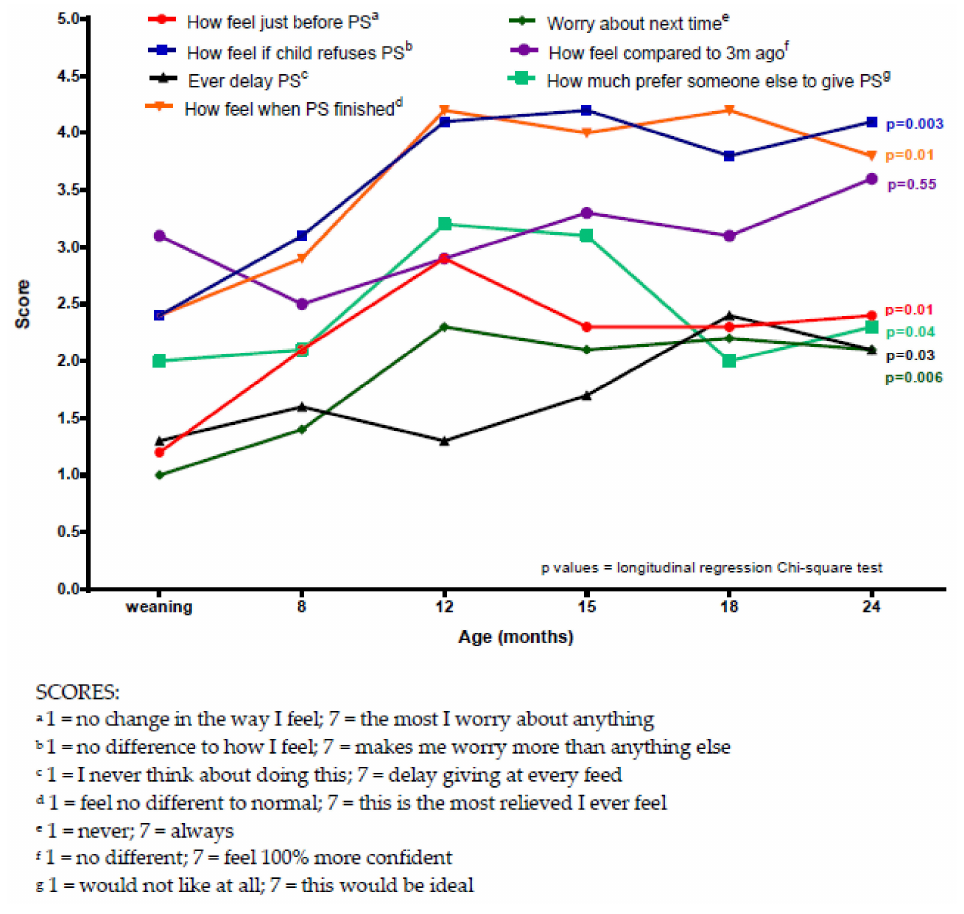
Figure 2. Mean maternal feelings about giving protein substitute to their child with phenylketonuria (PKU) at di ff erent child ages in the first two